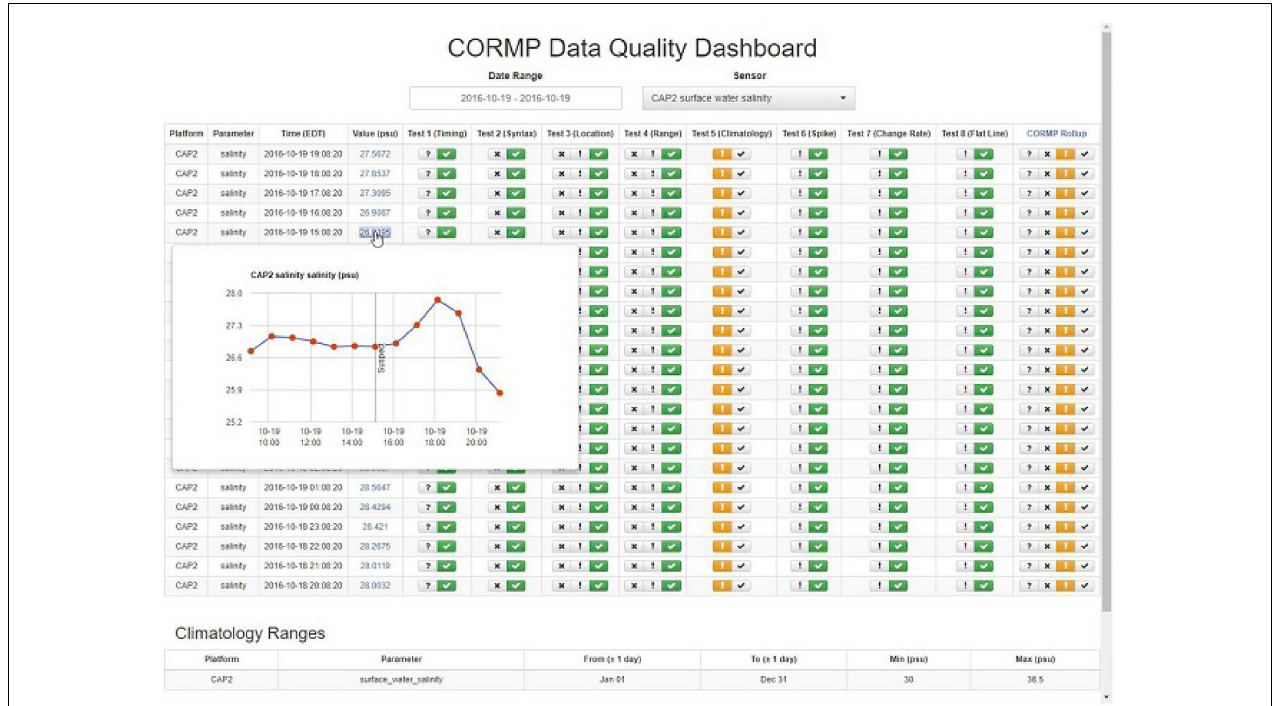
FIGURE 7 | The University of North Carolina-Wilmington Coastal Ocean Research and Monitoring Program (CORMP) recently implemented the Data Quality Dashboard and an auto-generated daily email with flags, which allowed operators to manually review flags to assess their validity, identify any trends, and accept or override flags. This example shows a flag triggered for coastal mooring salinity data after major rain event). Source: Jennifer Dorton, Southeast Coastal Ocean Observing Regional Association